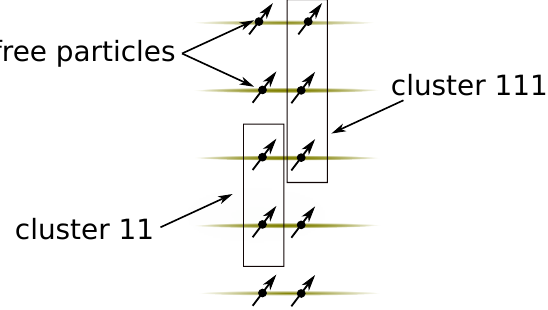
Figure 4. A figure to illustrate Equation (16). This specific configuration has five free particles, and two clusters. The energy of each cluster consists of two parts: The binding energy, which is calculated as in Section 2, and the center-of-mass part, which is determined by the confining harmonic oscillator. The energy, (cid:101) j , is obtained by using the harmonic approximation from the previous